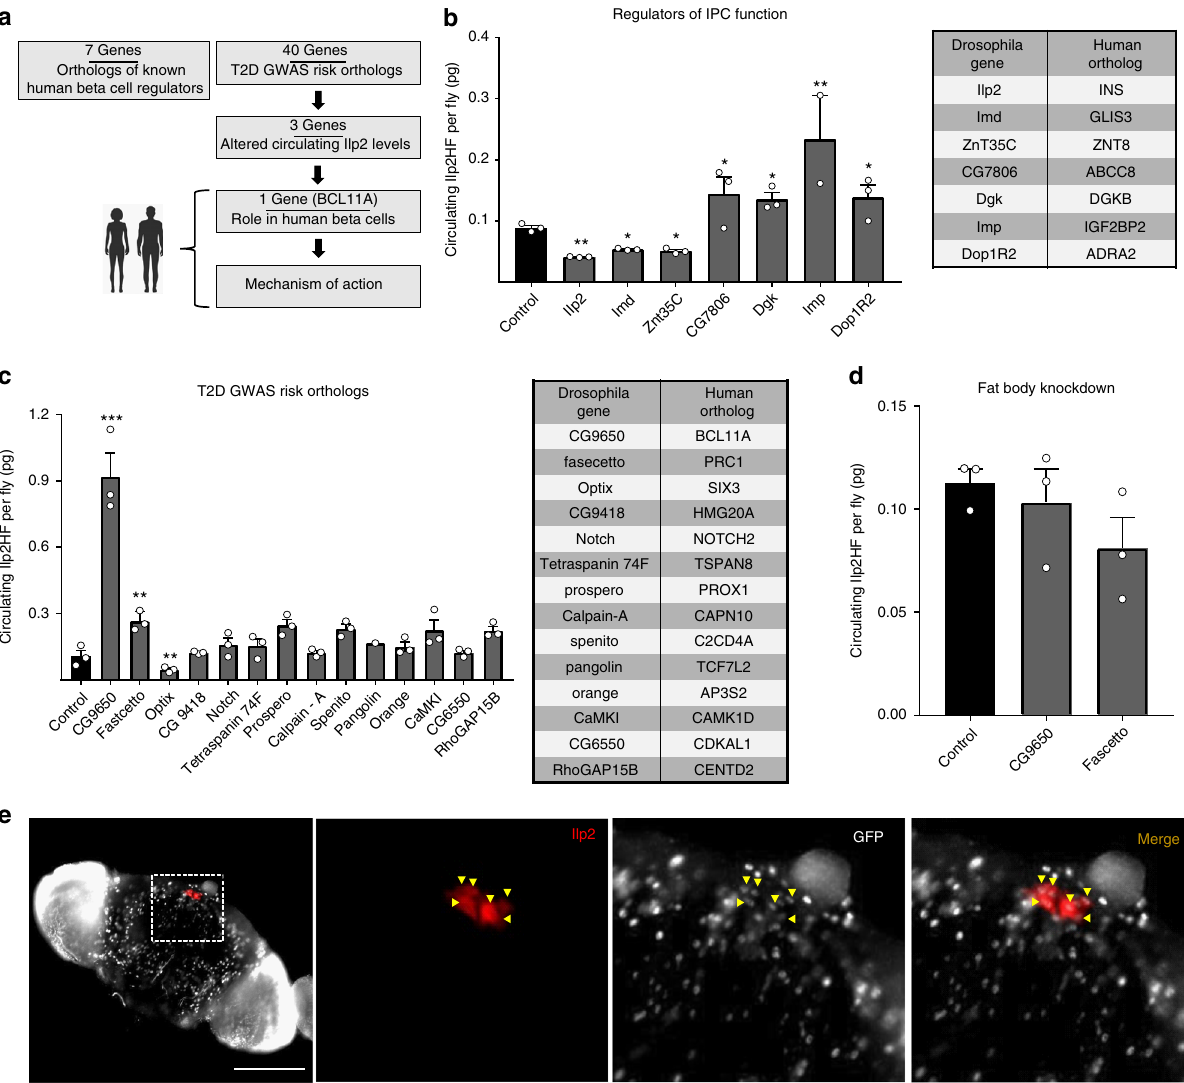
Fig. 1 Screening T2D GWAS risk gene in Drosophila Melanogaster. a Schematic summary of this study. b Circulating Ilp2HF levels (picogram, pg) in ad libitum fed adult fl ies with IPC-speci fi c RNAi knockdown of beta cell genes ( n = 3 independent experiments, sampled in duplicate). c Circulating Ilp2HF levels (pg) in ad libitum fed adult fl ies with IPC-speci fi c RNAi knockdown of GWAS candidate genes ( n = 3 independent experiments, sampled in duplicate). d Circulating Ilp2HF levels (pg) in ad libitum fed adult fl ies with fat body-speci fi c RNAi knockdown of CG9650, fascetto and Optix ( n = 3 experiments, sampled in duplicate). e Immunostaining of adult Drosophila brains with antibodies recognizing GFP (white) or Ilp2 (red), scale bar = 100 µ m. See also Supplementary Figure 1. The data presented as mean, error bars represent the standard error, and two-tailed t tests were used to generate p values. * p < 0.05, ** p < 0.01, *** p <